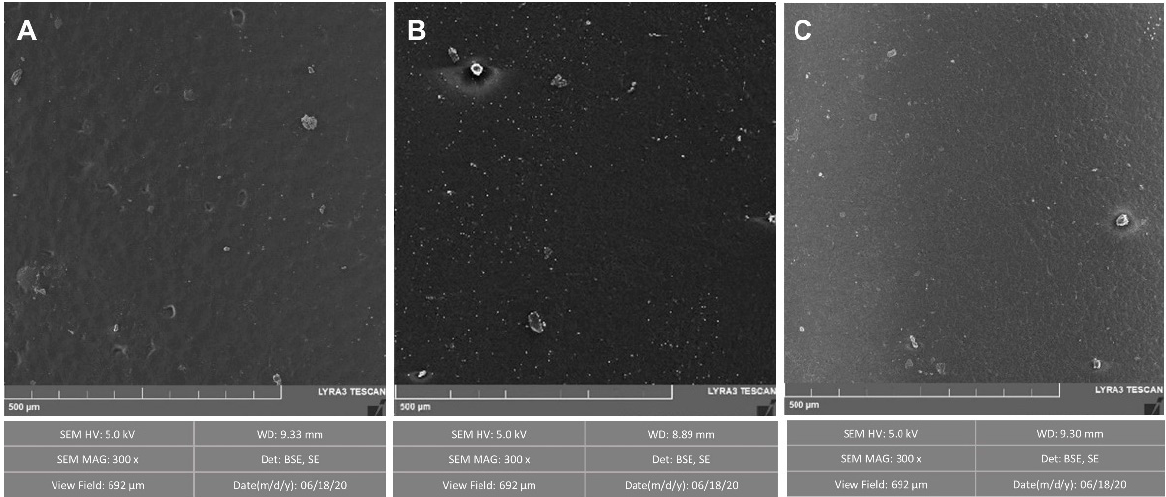
Figure 3. SEM micrographs of PHO films functionalized with metal nanoparticles. ( A ): PHO; ( B ): PHO + 3.5 mM AgNO 3 ; ( C ): PHO + 0.07% CuONPs.